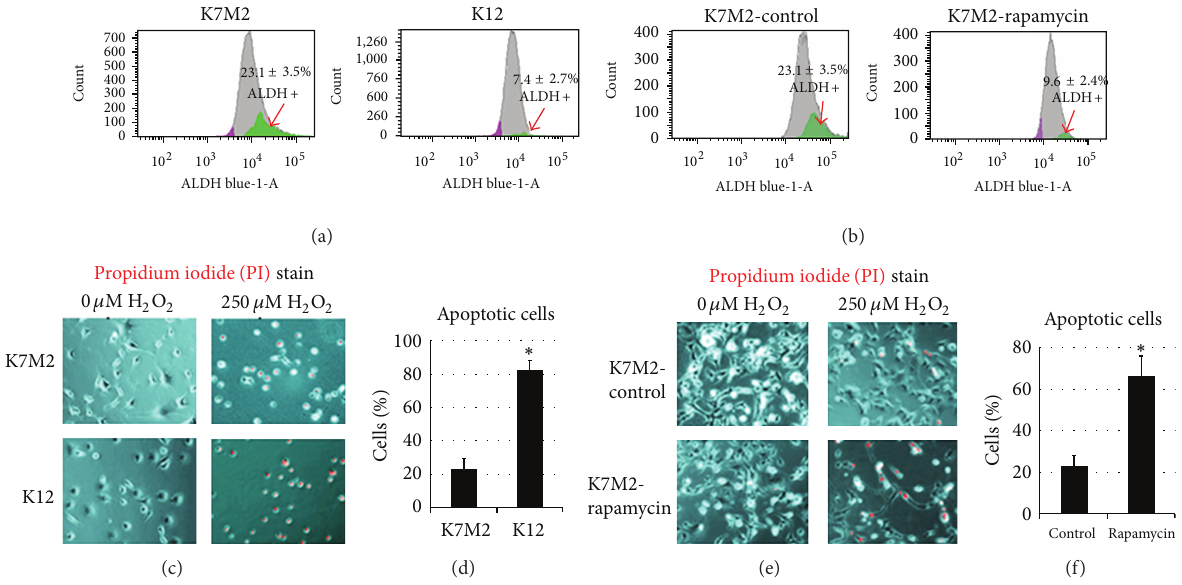
Figure 2: Rapamycin treatment reduces ALDH activity and sensitizes K7M2 cells to oxidative stress. (a) ALDH activity was detected in K7M2 and K12 cells using FACS analysis and the relative amount of cells positive for ALDH is shown for each cell population. (b) K7M2 cells were treated with rapamycin or DMSO only (control) and analyzed by FACS as in (a). (c) K7M2 and K12 cells were treated with or without H 2 O 2 (250 𝜇 M) and apoptosis was detected using PI staining. (d) A quantitative analysis of (c) illustrating the percentage of apoptotic cells after H 2 O 2 treatment compared to untreated controls. (e) K7M2 cells were treated with or without H 2 O 2 , in the presence or absence (DMSO only control) of rapamycin, and apoptotic cells were detected as in (c). (f) A quantitative analysis of (e) illustrating the percentage of apoptotic cells after H 2 O 2 compared to untreated controls. Asterisks ( ∗ ) indicate statistically significant differences ( 𝑃 < 0.05